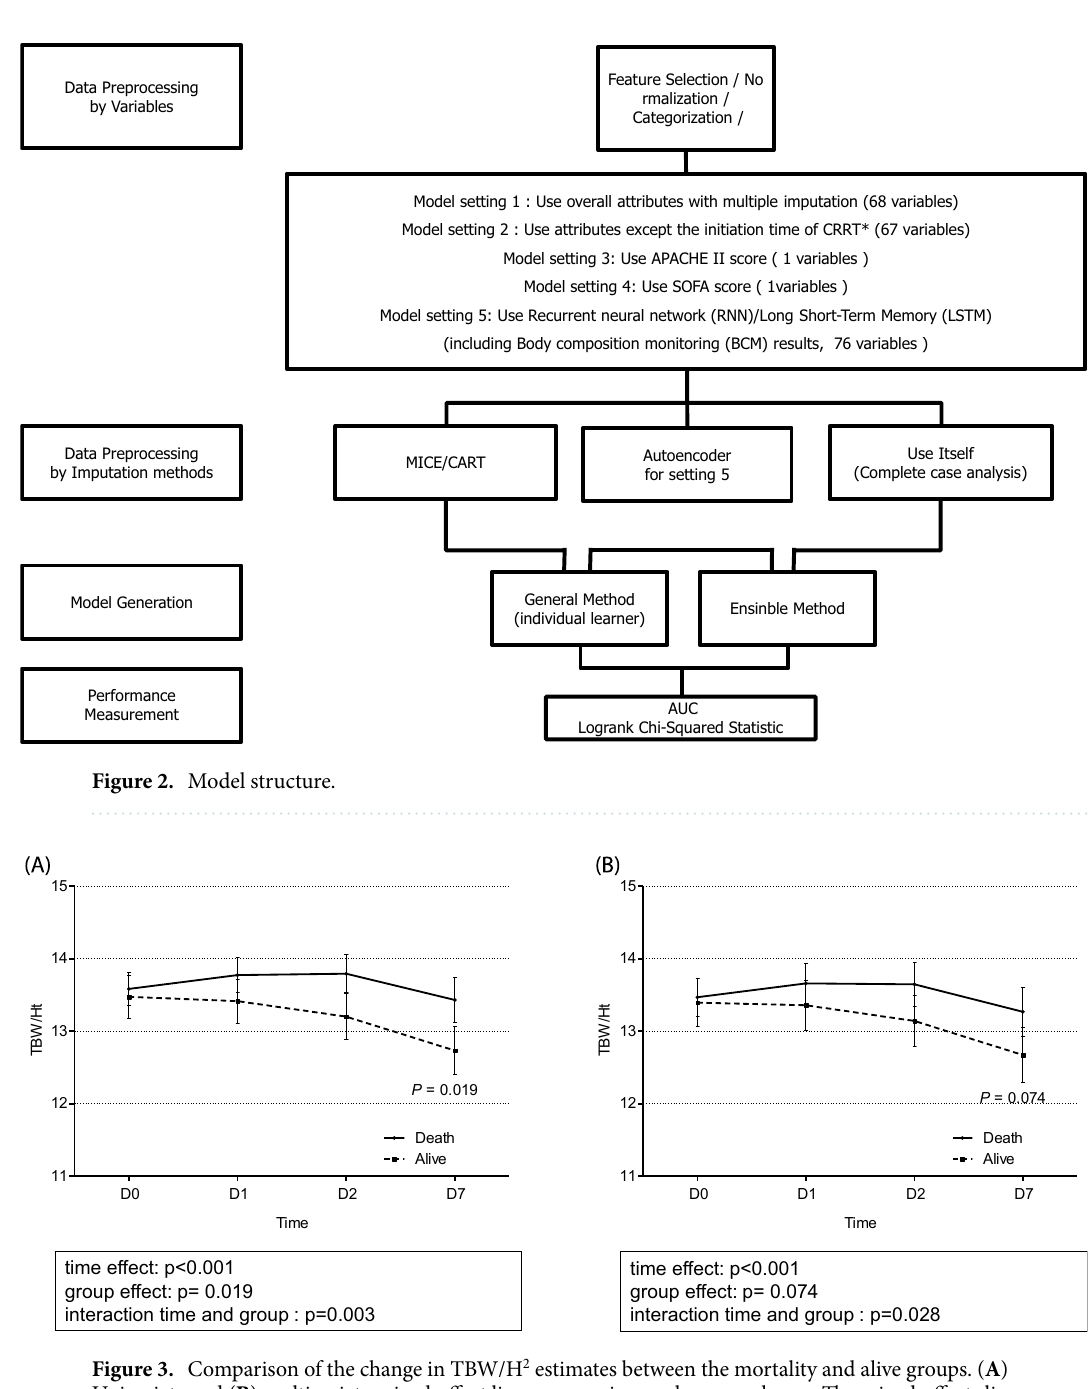
Figure 3. Comparison of the change in TBW/H 2 estimates between the mortality and alive groups. ( A ) Univariate and ( B ) multivariate mixed-effect linear regression analyses are shown. The mixed-effects linear regression analysis between the two groups included the association with volume status at CRRT initiation, adjusted for age, sex, age-modified CCI, DM, hypertension, SOFA score, urine output for 6 h, and serum albumin level, MDRD, and eGFR at CRRT